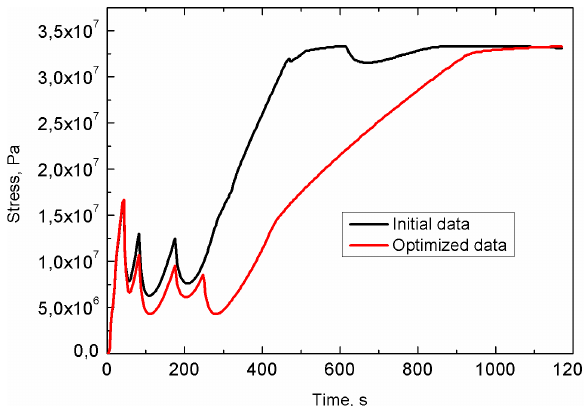
Figure 12: Comparison of initial and optimized temperatures on surface web.